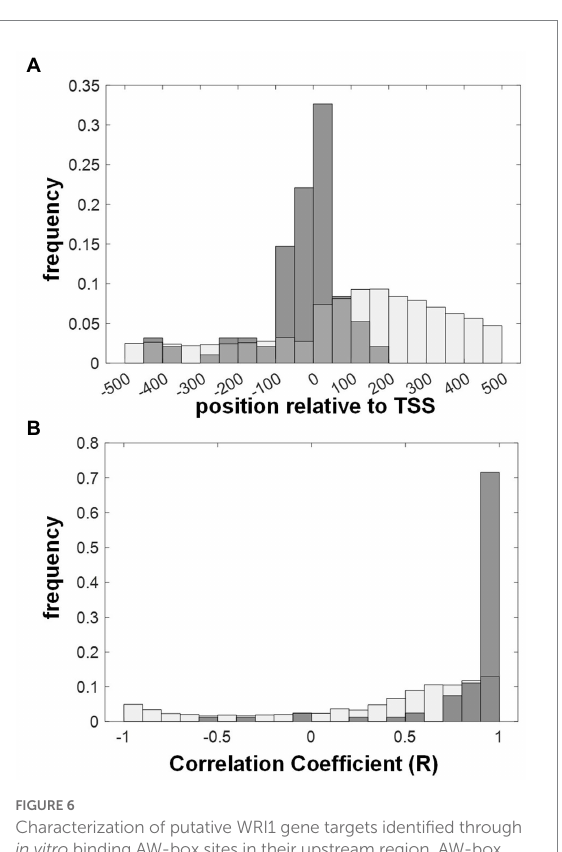
FIGURE 6 Characterization of putative WRI1 gene targets identified through in vitro binding AW-box sites in their upstream region. AW-box sites are classified as binding WRI1 for k D values below 200 nM (see Figure 4). (A) Positional distribution of WRI1 binding AW- boxes relative to the transcriptional start site (TSS) in A. thaliana (Gray bars). White bars: position of genome wide detected AW- sites. (B) Co-expression (Pearson Correlation) of A. thaliana genes with WRI1 during seed development. Gray bars: correlation coefficients for genes for which at least one upstream motif binds WRI1. White bars: genes with AW-box hit. Pearson Correlation coefficients are based on gene expression data for embryos in 7 seed developmental stages (Schneider et al.,